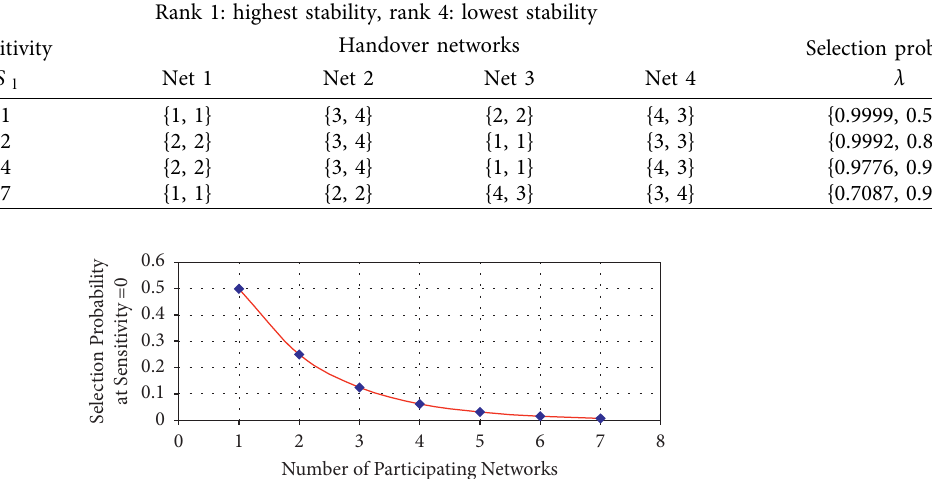
Table 9: Network handover ranking of transitional states map as a function of threshold, sensitivity, and selection probability. Rank 1: highest stability, rank 4: lowest stability